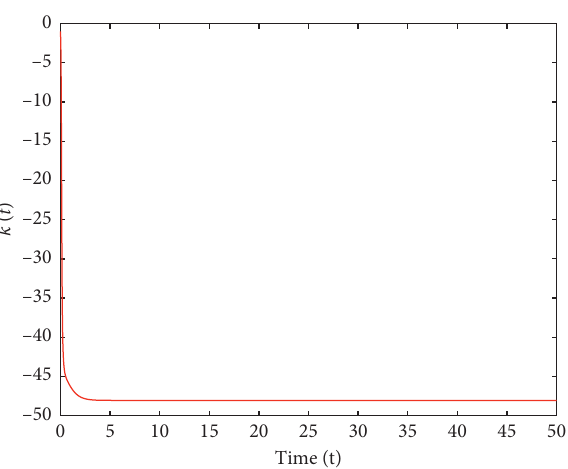
Figure 8: k ( t ) tends to